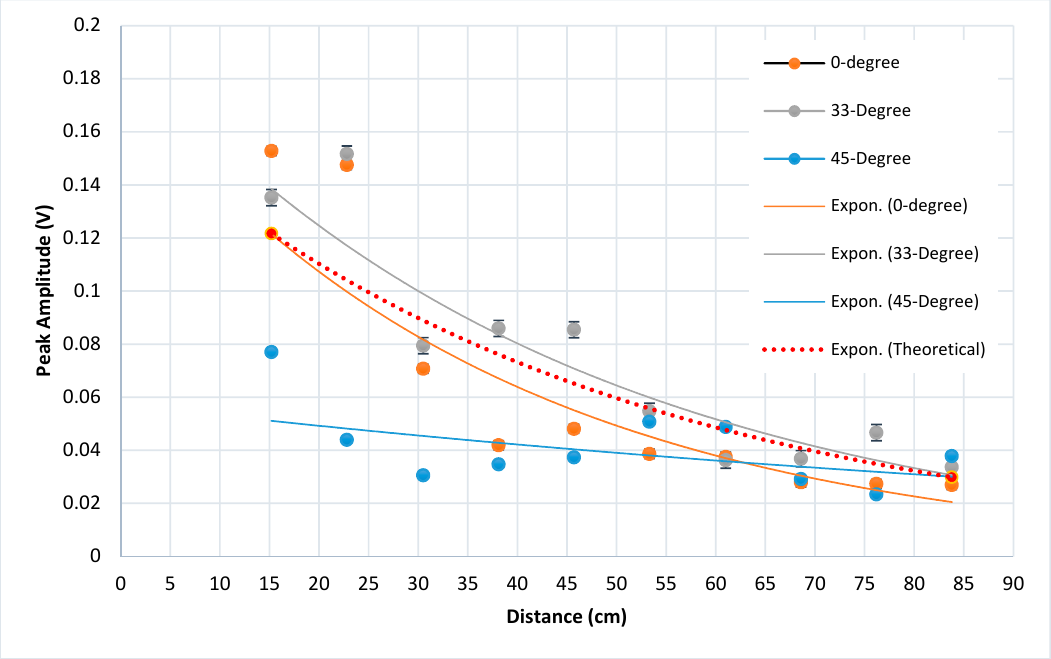
Figure 16. Comparison of the peak amplitudes and attenuation curves for the 0, 33, and 45 degree specimens.